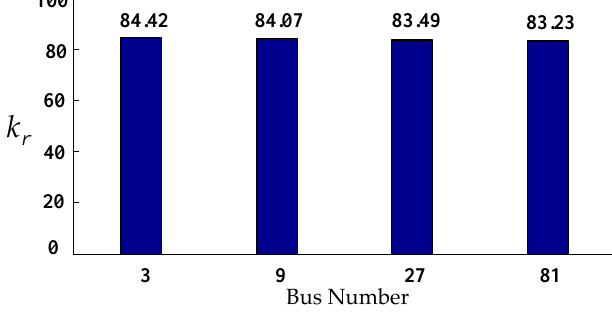
Figure 9. k r corresponds to the change of bus number.